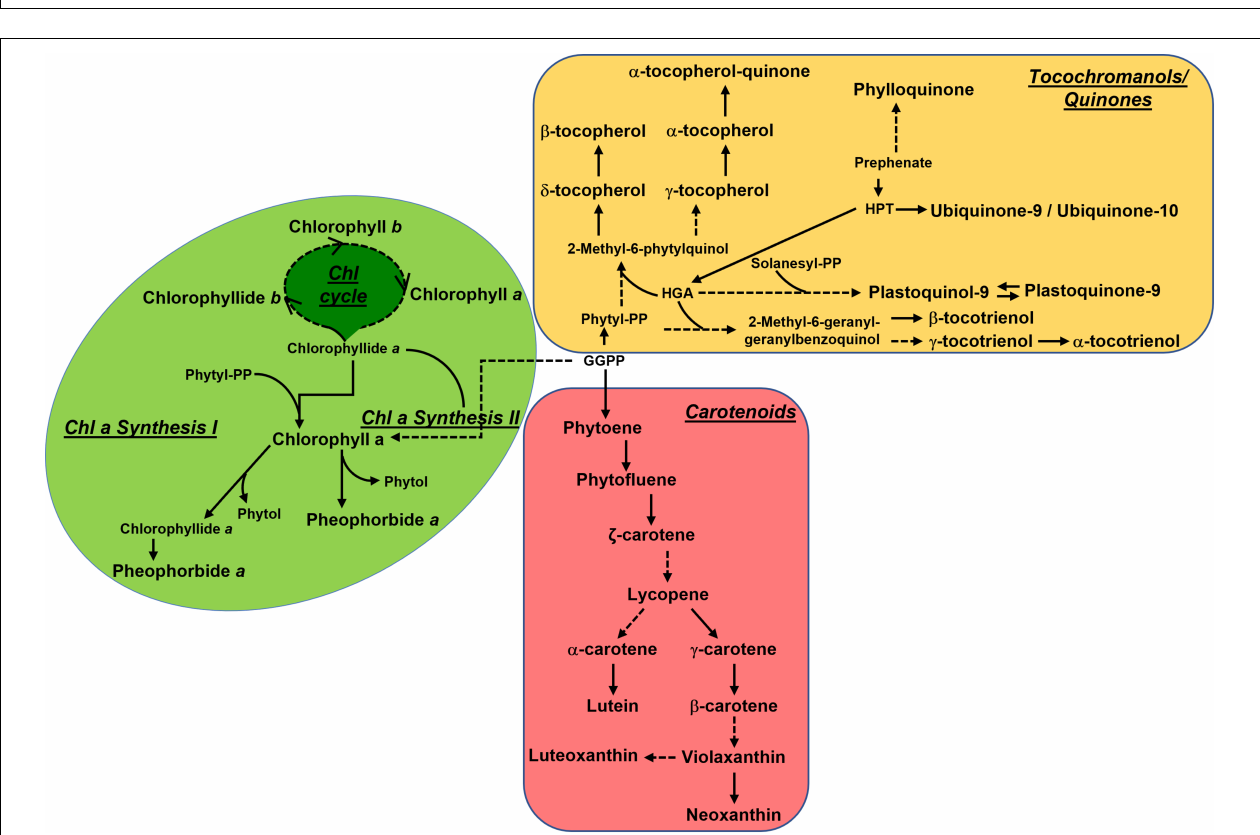
FIGURE 6 | WT and mutated GF proteins. Alignment of the native and mutated GF proteins, including the gf-gf 5 spontaneous mutants and the CRISPR-generated mutants of lines 2B19 and 12A41. Alignments were obtained with T-Coffee Expresso and visualized with Jalview.